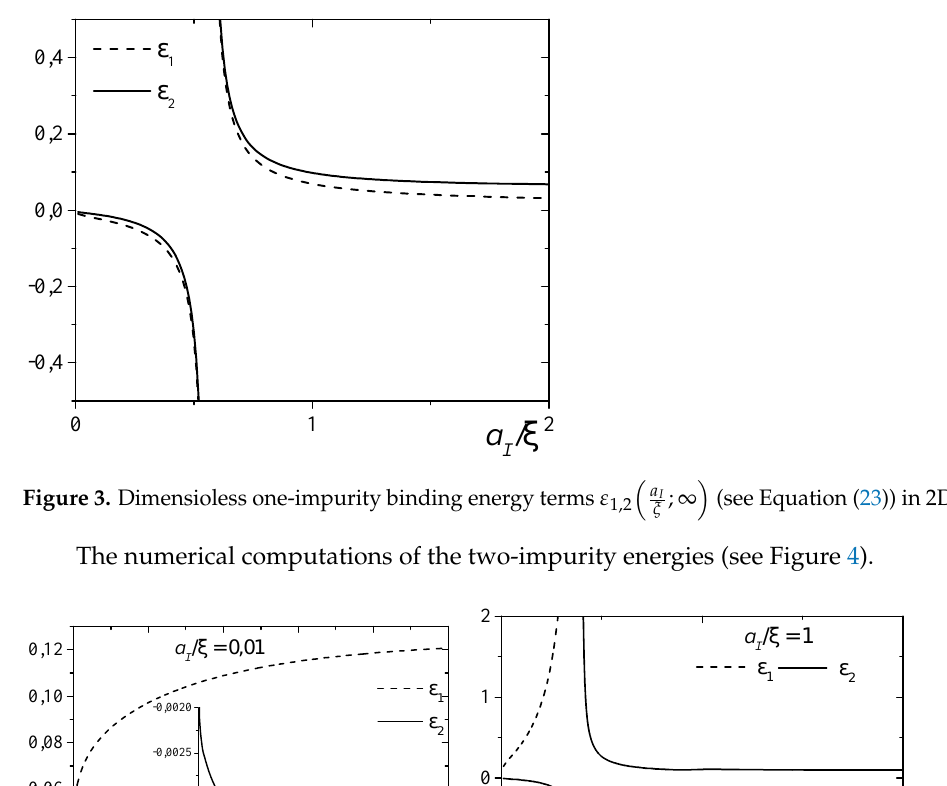
Figure 4. The two-impurity dimensionless binding energy corrections ε 1,2 Bose